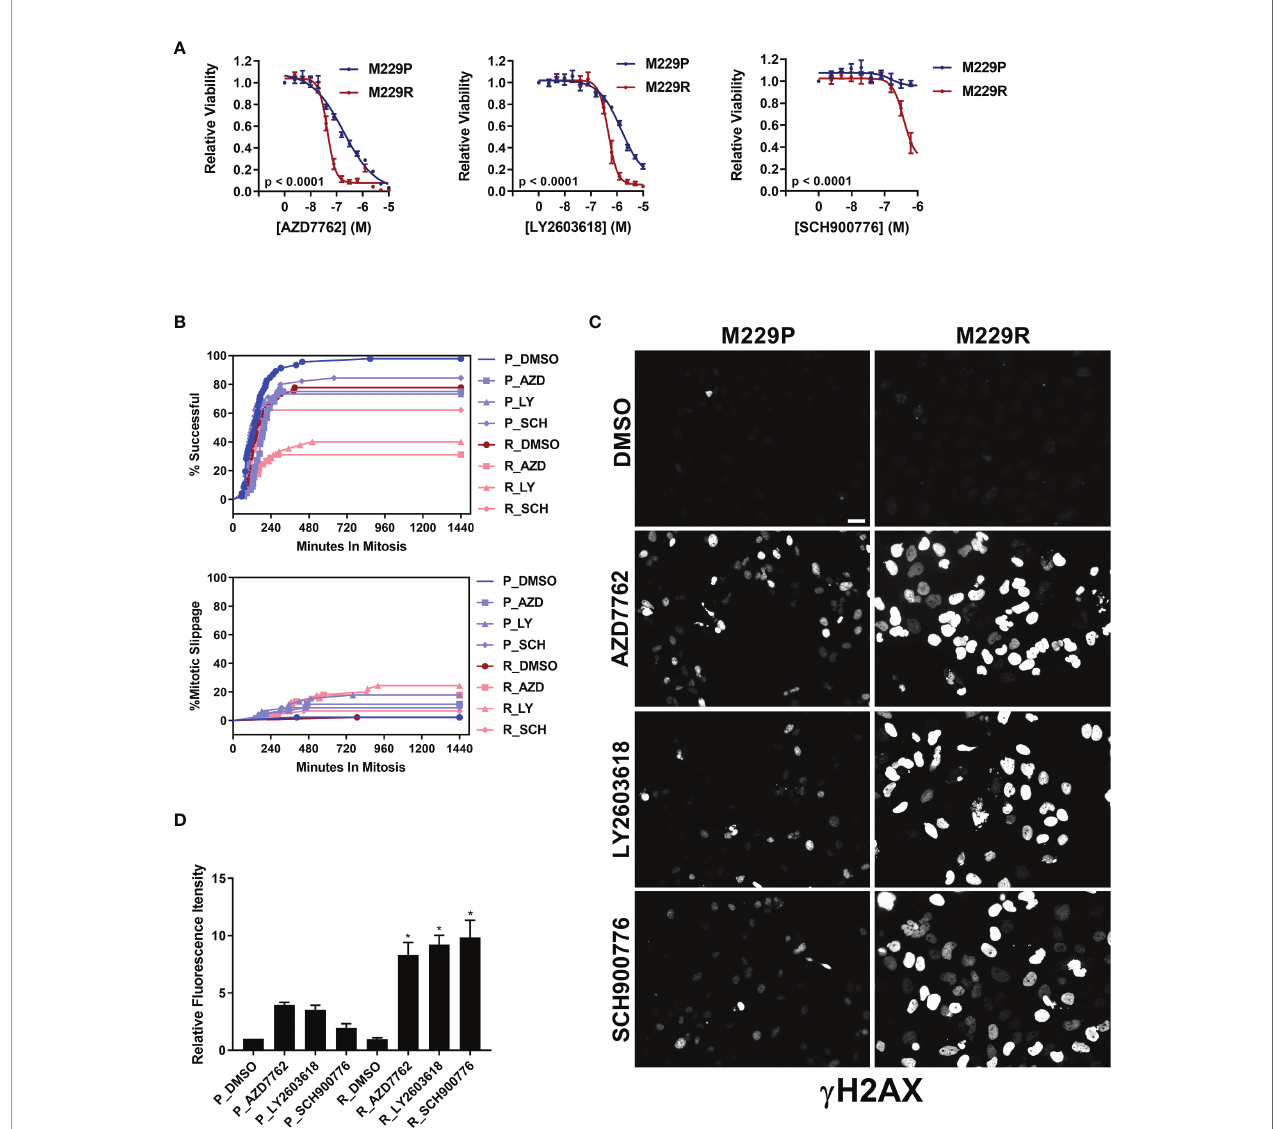
FIGURE 4 | M229R cells are vulnerable to Chk1/2 inhibitors. (A) M229P/R cells were seeded into 384-well plates and treated with AZD7762, LY2603618, and SCH900776 as indicated. After 72 h, viability was measured as described in Materials and Methods . Data are represented as mean ± SE of the technical replicate averages for each of the biological replicates (n = 3). IC 50 and E max values are listed in Supplementary Table S3 . (B) M229P/R cells were engineered to express mScarlet-H2A and EGFP-TUBA1B as described in the Materials and Methods . Cells were seeded into glass-bottom 96-well plates and the next day the cells were treated with 100 nM AZD7762, 1 µM LY2603618, or 1 µM SCH900776. Mitotic rate/outcome was measured on the Cytation 3 microscope setup as described in Materials and Methods . At least 40 cells were analyzed per treatment condition. (C) M229P/R cells were treated with 100 nM AZD7762, 1 µM LY2603618, or 1 µM SCH900776 for 24 h. The cells were subsequently fi xed and stained with an antibody raised against p- g H2AX. Scale bar = 10 µM. (D) Quanti fi cation of g H2AX from the experiment in Figure 4C was as described in Materials and Methods . Statistical analysis was performed with one-way ANOVA analysis, * indicates p < 0.01 vs the M229R DMSO group. None of the compound-treated M229P groups was statistically signi fi cant in comparison to M229P DMSO. Data are represented as mean ± SE for n = 3 biological replicates. IC 50 and E max values are listed in ( Supplementary Table S3